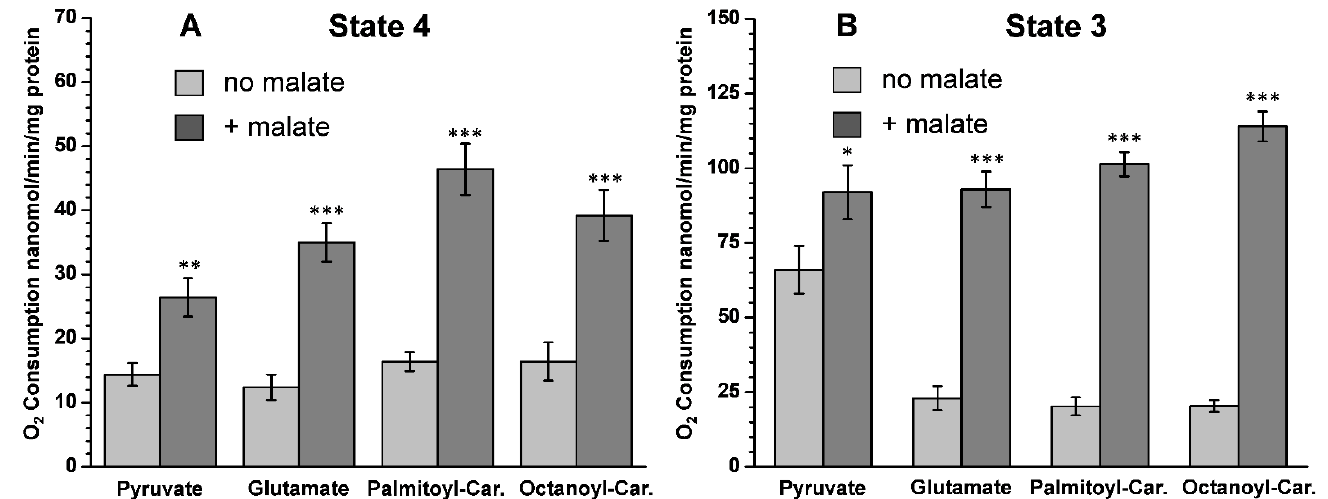
Figure 1. The addition of malate stimulates the oxidation of pyruvate, glutamate, C16, and C8 acylcarnitines by mouse kidney mitochondria. ( A ) The mitochondrial metabolic State 4 (resting respiration); ( B ) Metabolic State 3 (oxidative phosphorylation) initiated by adding 150 µM ADP. The incubation medium contained: 125 mM KCl, 10 mM MOPS, pH 7.2, 2 mM MgCl 2 , 2 mM KH 2 PO 4 , 10 mM NaCl, 1 mM EGTA, 0.7 mM CaCl 2, and if added, malate 2 mM. Substrates: Pyruvate 2.5 mM, glutamate 5.0 mM, L-palmitoylcarnitine 10 µM, L-octanoylcarnitine 10 µM. Substrates were added before the addition of 0.3 mg kidney mitochondria. The addition of 150 µM ADP initiated State 3 respiration. The light gray columns represent the rate of O 2 consumption with a substrate alone; the dark gray columns represent a substrate + malate. Consider the difference in the Y scale values between Figures 1A and 1B. Statistics: * — p < 0.5; ** — p < 0.05; *** — p < 0.001. The number of experiments (separate isolations of kidney mitochondria) for each substrate: without malate n = 5; with malate n = 8.